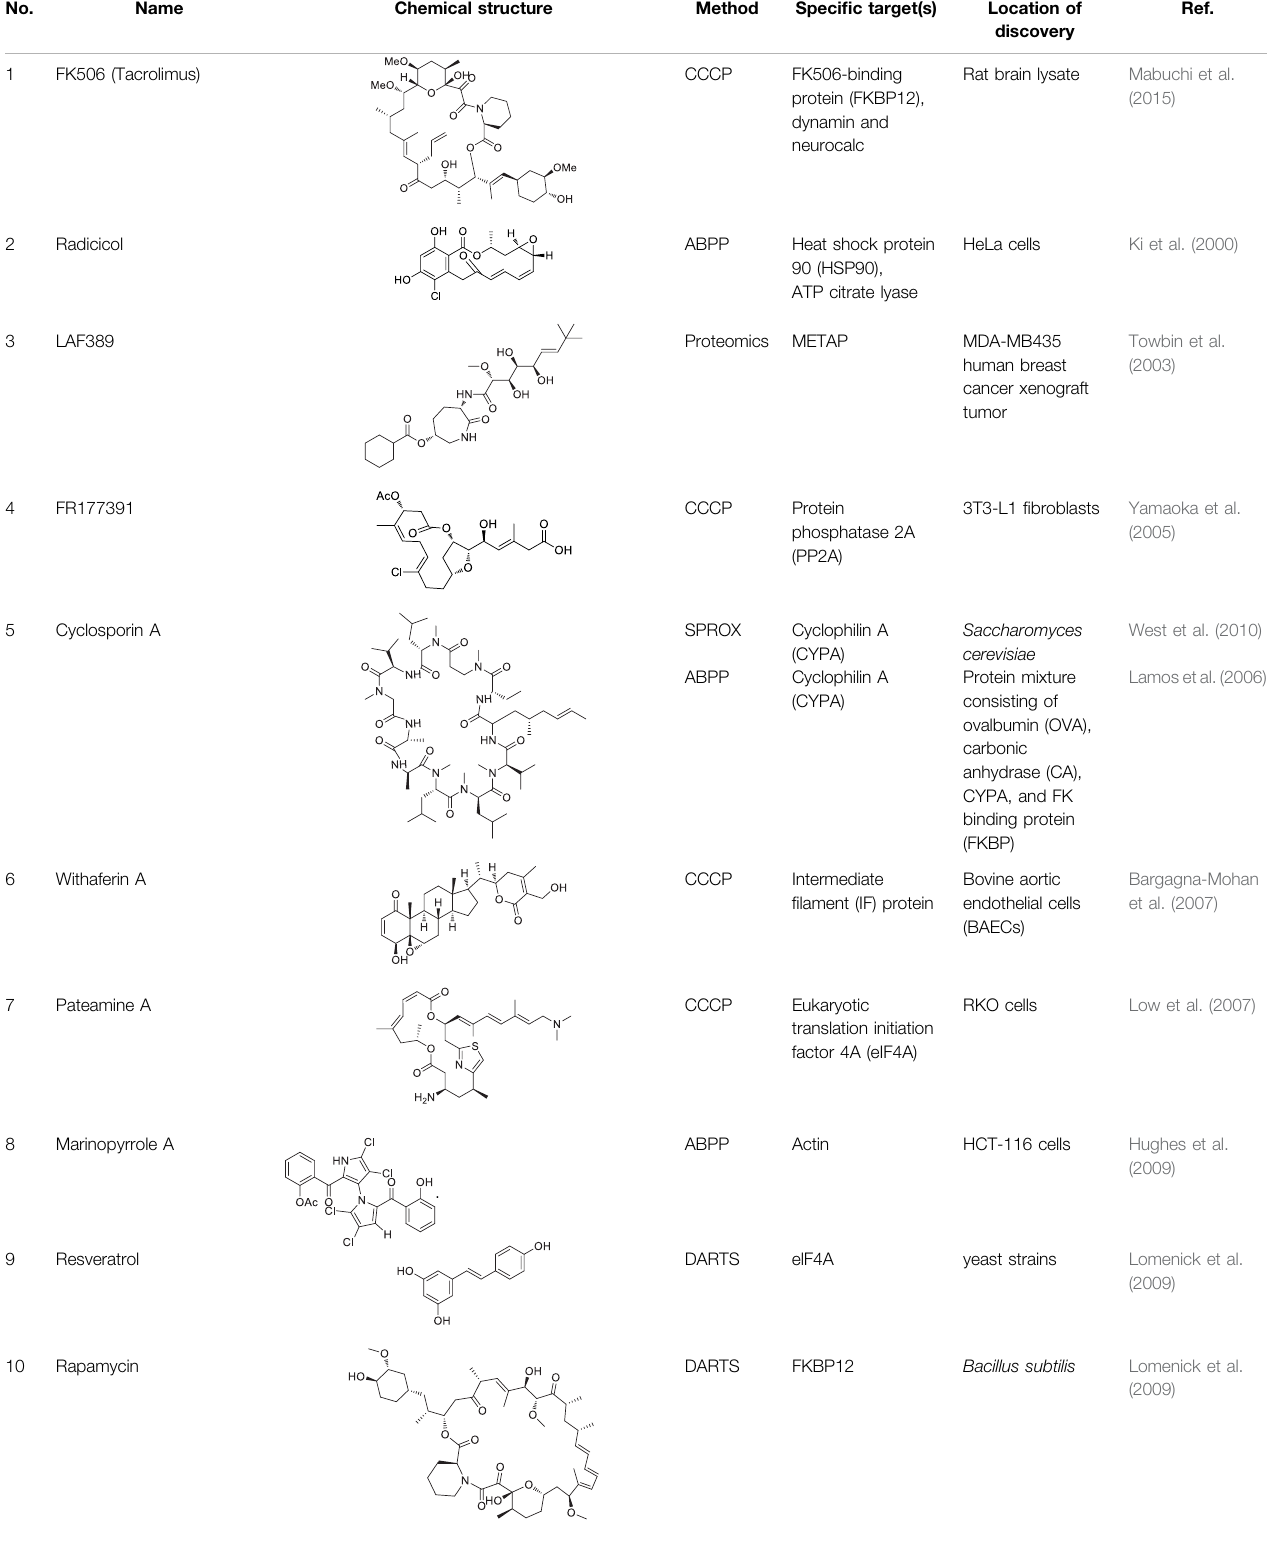
TABLE 1 | Chemical structures, identi fi cation methods, speci fi c drug targets, and biological applications of known natural products.